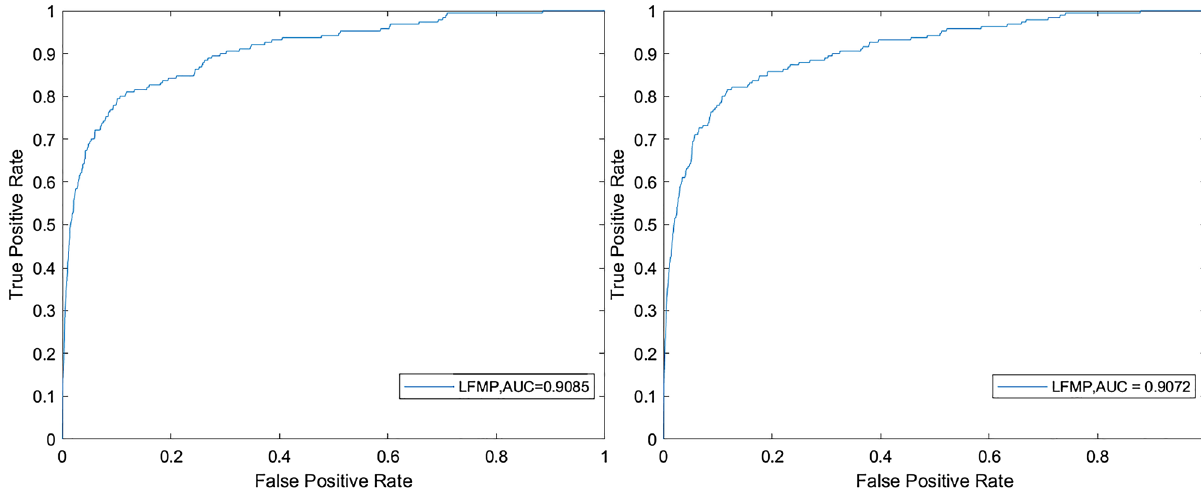
Figure 1. The performance of LFMP in terms of ROC curves and AUC based on 190 known lncRNA-disease associations under the framework of LOOCV frameworks (Left) and fivefold frameworks (Right).